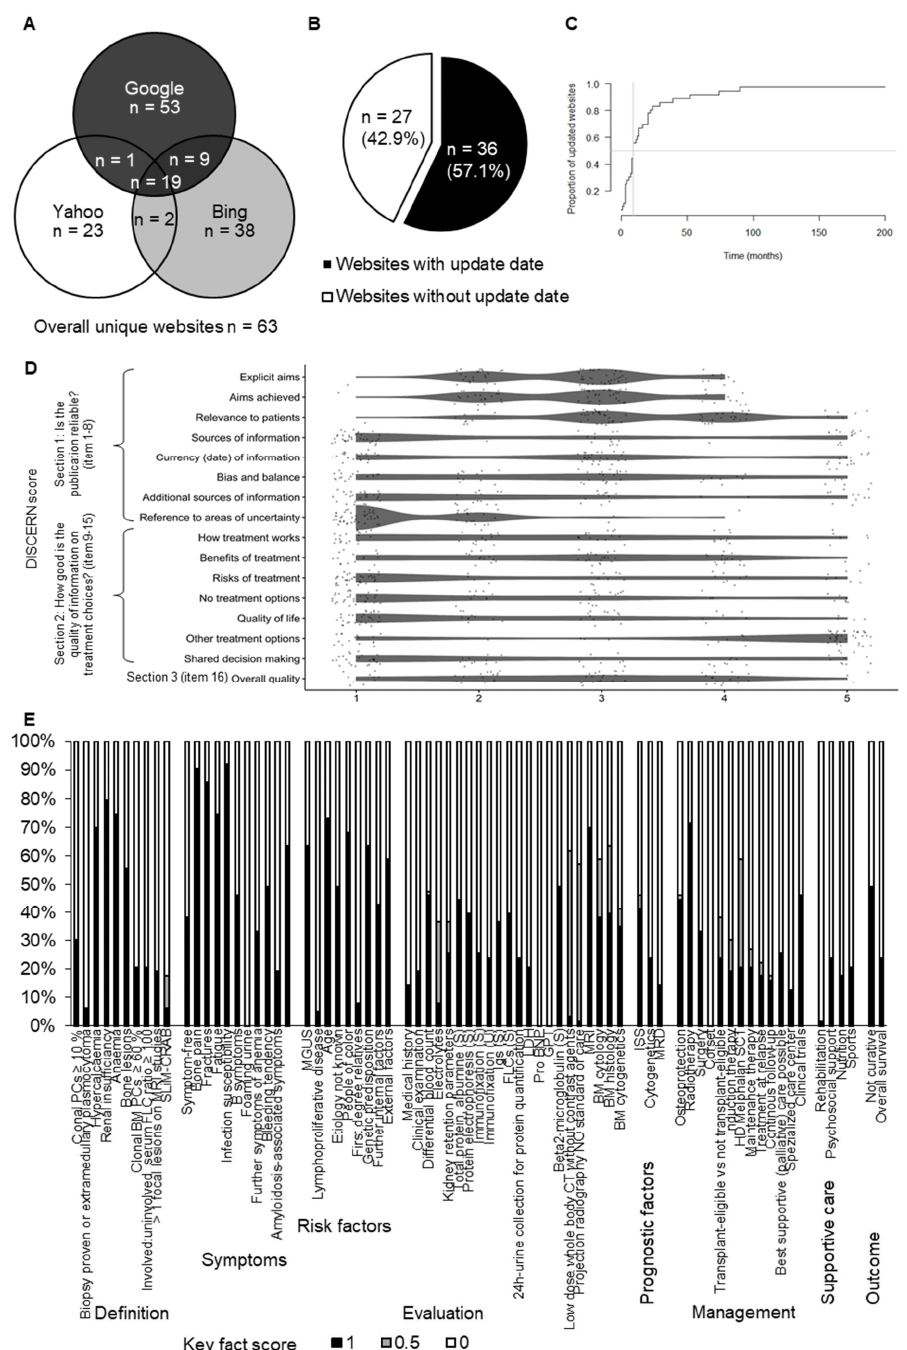
Figure 1. Characterization of unique websites. ( A ) Venn diagram indicating the number of duplicate overlaps between the search engines. Overall 63 unique websites were identified. ( B ) Pie chart showing the proportion of websites with and without indicated update date. ( C ) The inverse Kaplan- Meier curve shows the proportion of website updates by time. Only websites with an indicated update date were included ( n = 36). ( D ) A scatter dot plot shows the score result reached by every single website ( n = 63) for each item of the DISCERN score. The categorial item scoring ranges between 1 (not addressed/fulfilled) and 5 (fully addressed/fulfilled). To avoid a visual overlap the dots were spread around the respective score category. ( E ) For each of the 73 key fact items, the proportion of websites ( n = 63) fully (1), partially (0.5) or not (0) addressing the respective contents is shown. The results are grouped by key fact